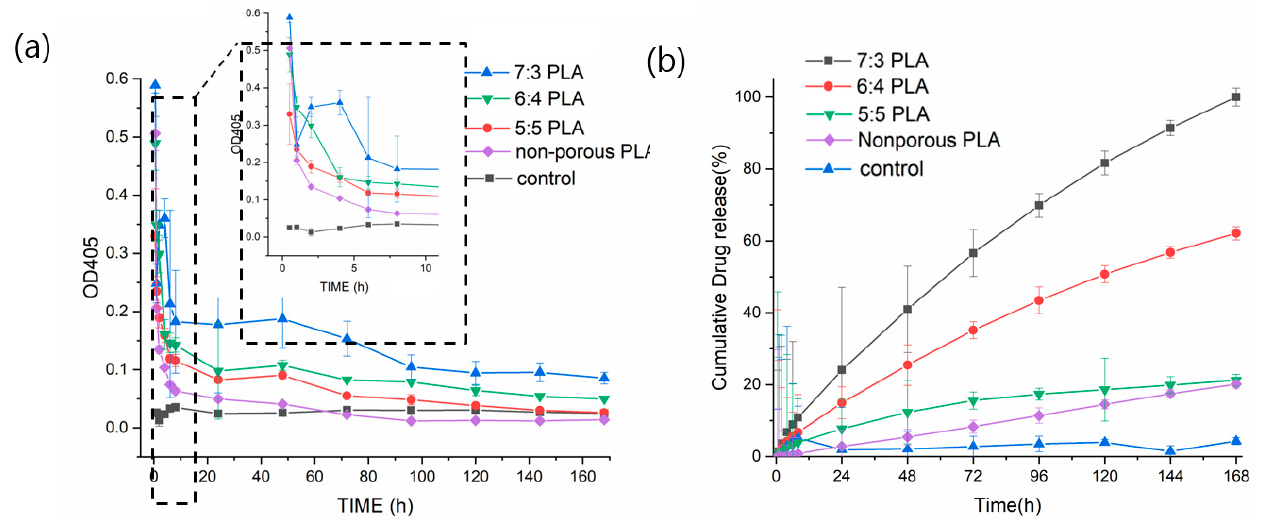
Figure 7. In vitro release profiles of gentamicin-loaded non-porous and porous 5:5, 6:4, and 7:3 PLA fibers for 7 d, ( a ) OD 405 curves and ( b ) cumulative release profiles.